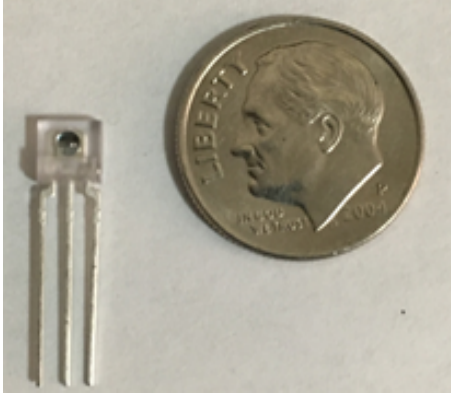
Figure 3. TAOS TSL235R light-to-frequency